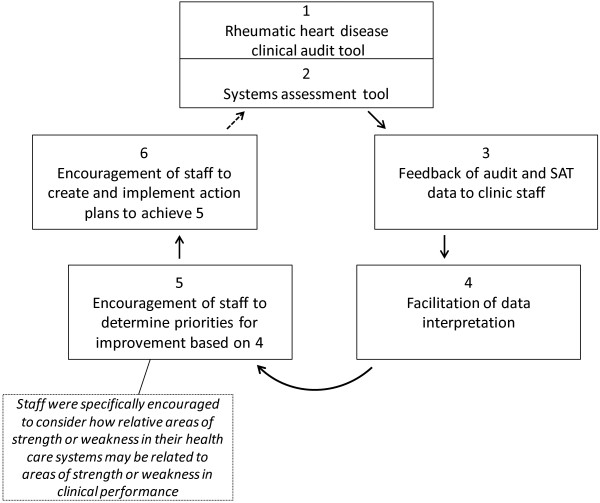
Continuous quality improvement cycle.